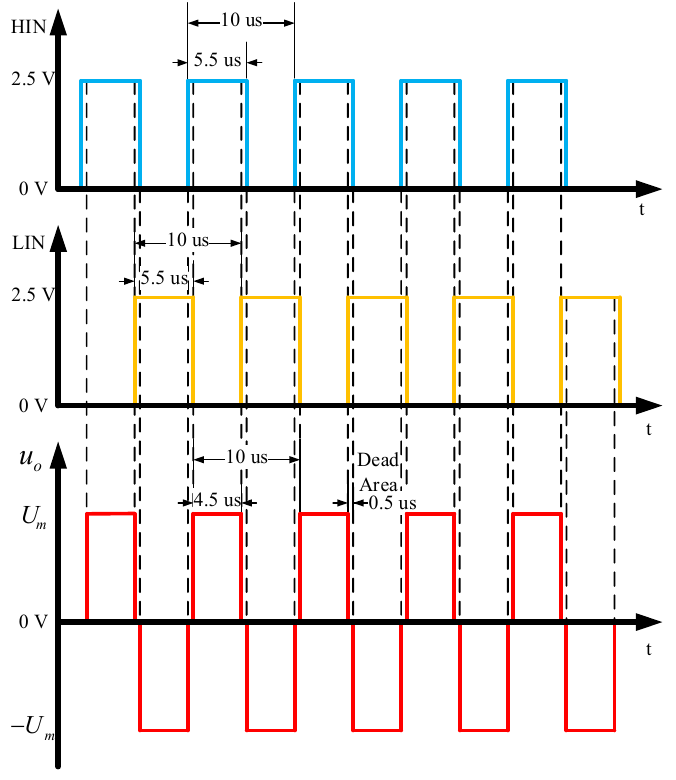
Figure 6. The control timing sequence of CW pulse generator.